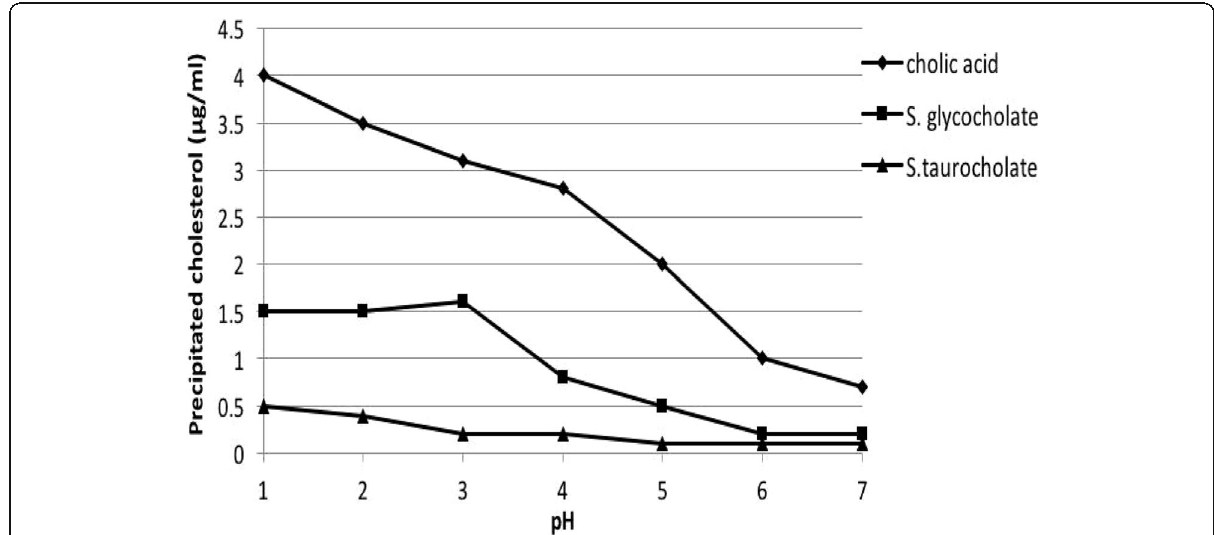
Fig. 5 The effect of pH on the co-precipitation of cholesterol with cholic acid (10 mM), sodium glycocholate (5 mM), or sodium taurocholate (5 mM). Each point is the mean of two independent